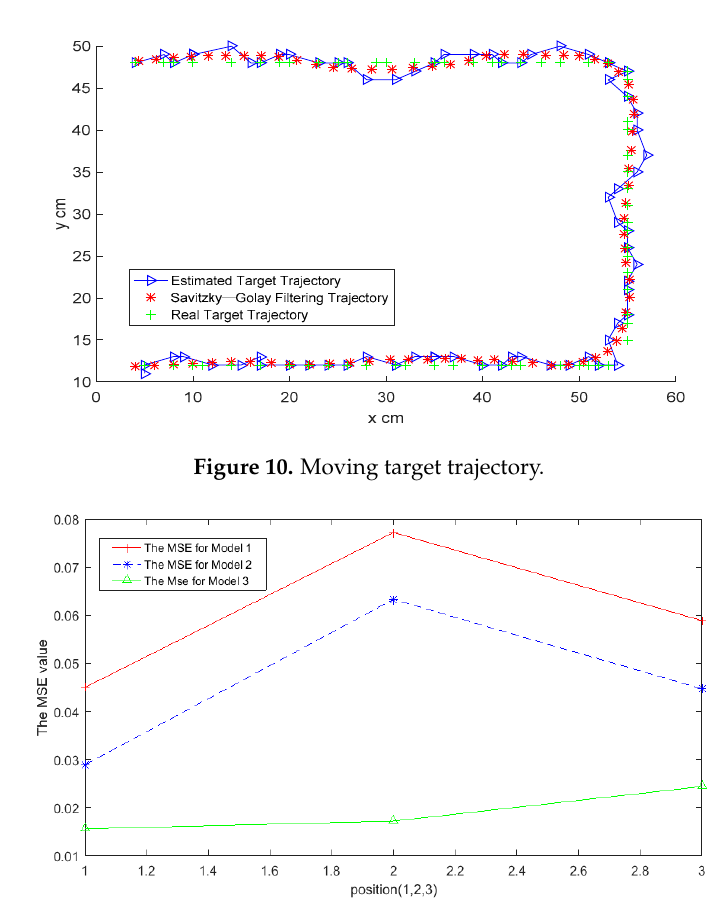
Figure 11. The positioning error of different approaches.